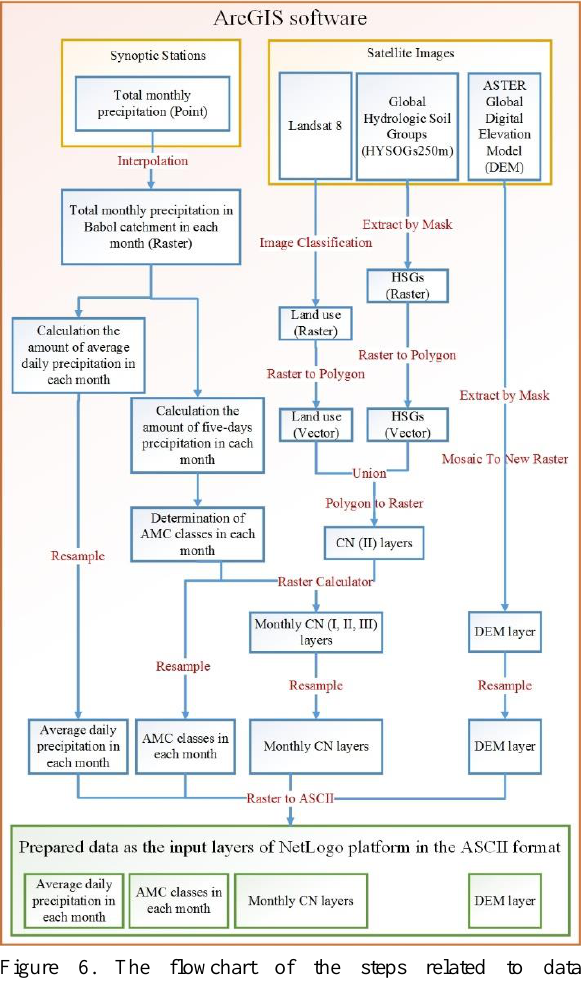
Figure 6. The flowchart of the steps related to data preparation and data input of the NetLogo 6.0.4